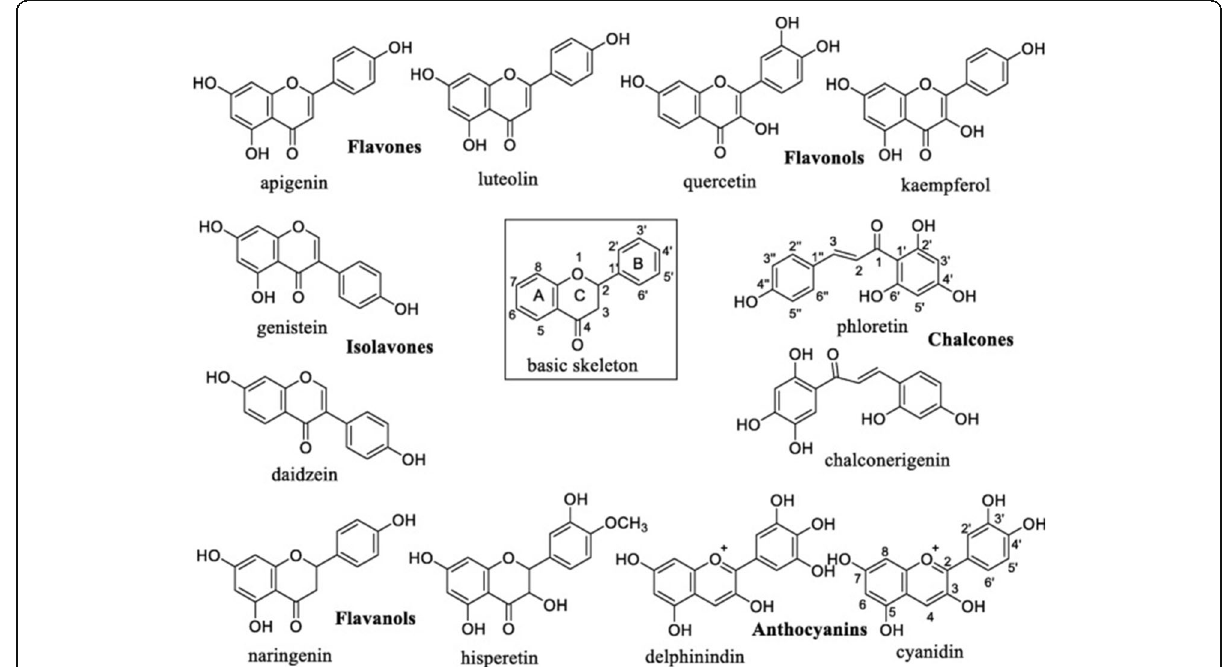
Fig. 1 Chemical structure of flavonoids and their classes